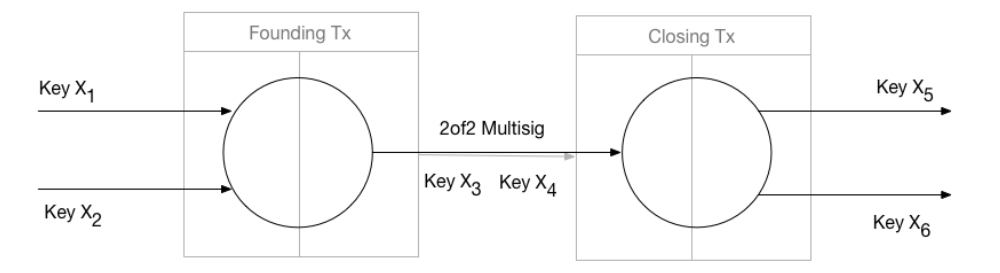
Figure 8. Keys in a channel